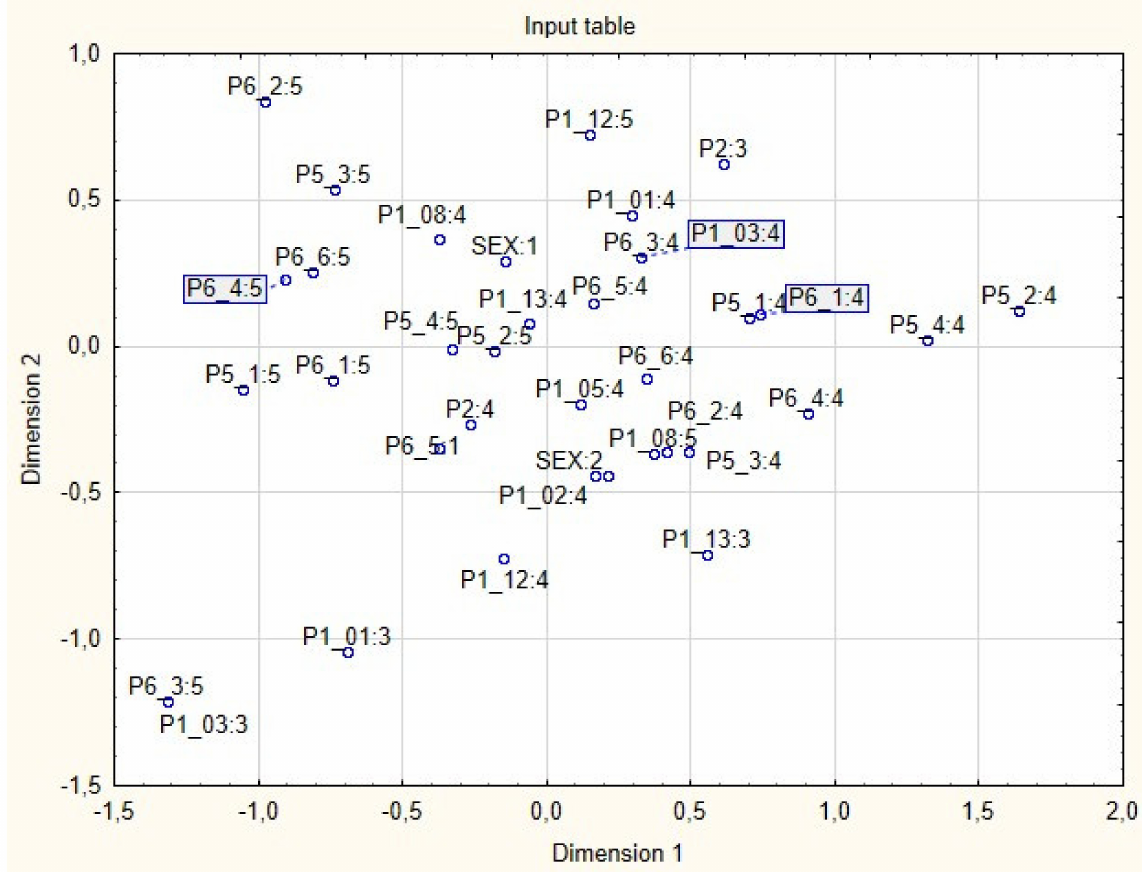
Figure 1. Two-dimensional perception map for the variables gender and subjective evaluation of salary in energy